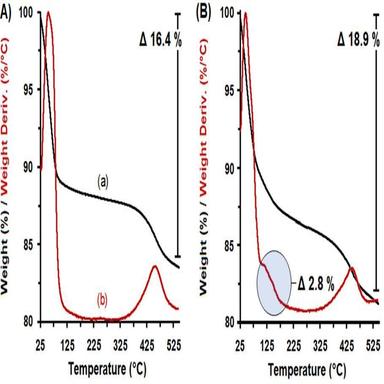
Thermal analysis of bentonite (A) and CM-Bent (B). TGA (a) and DTG (b).